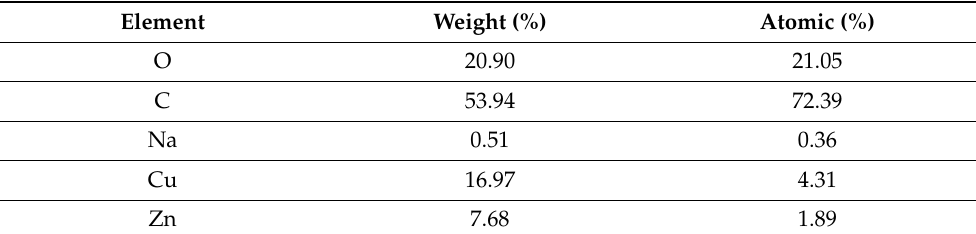
Table 2. Element quantification with EDX for the Cu/ZnO/activated carbon material.